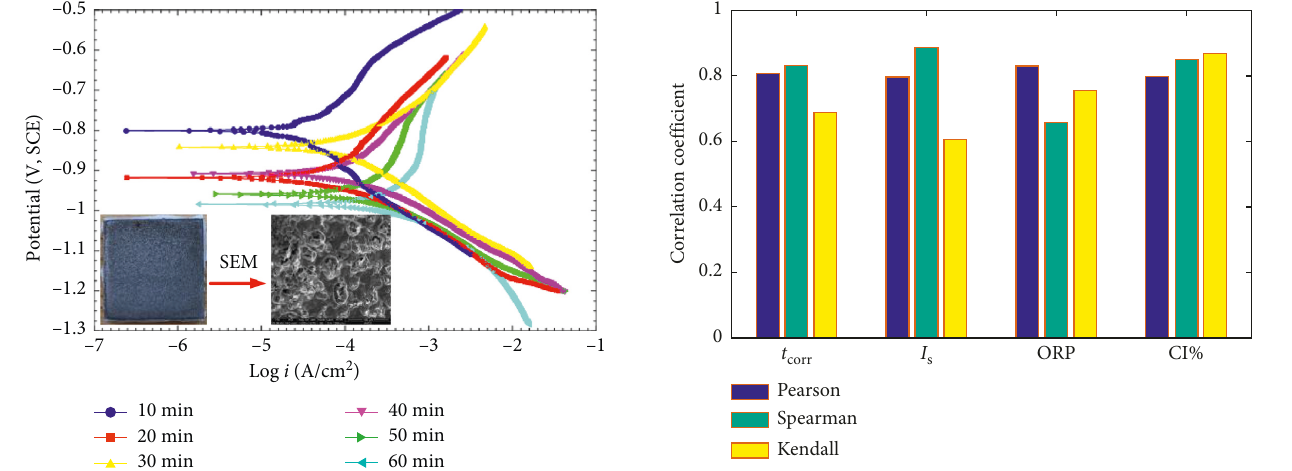
Figure 5: Correlation coefficient between input variables and i